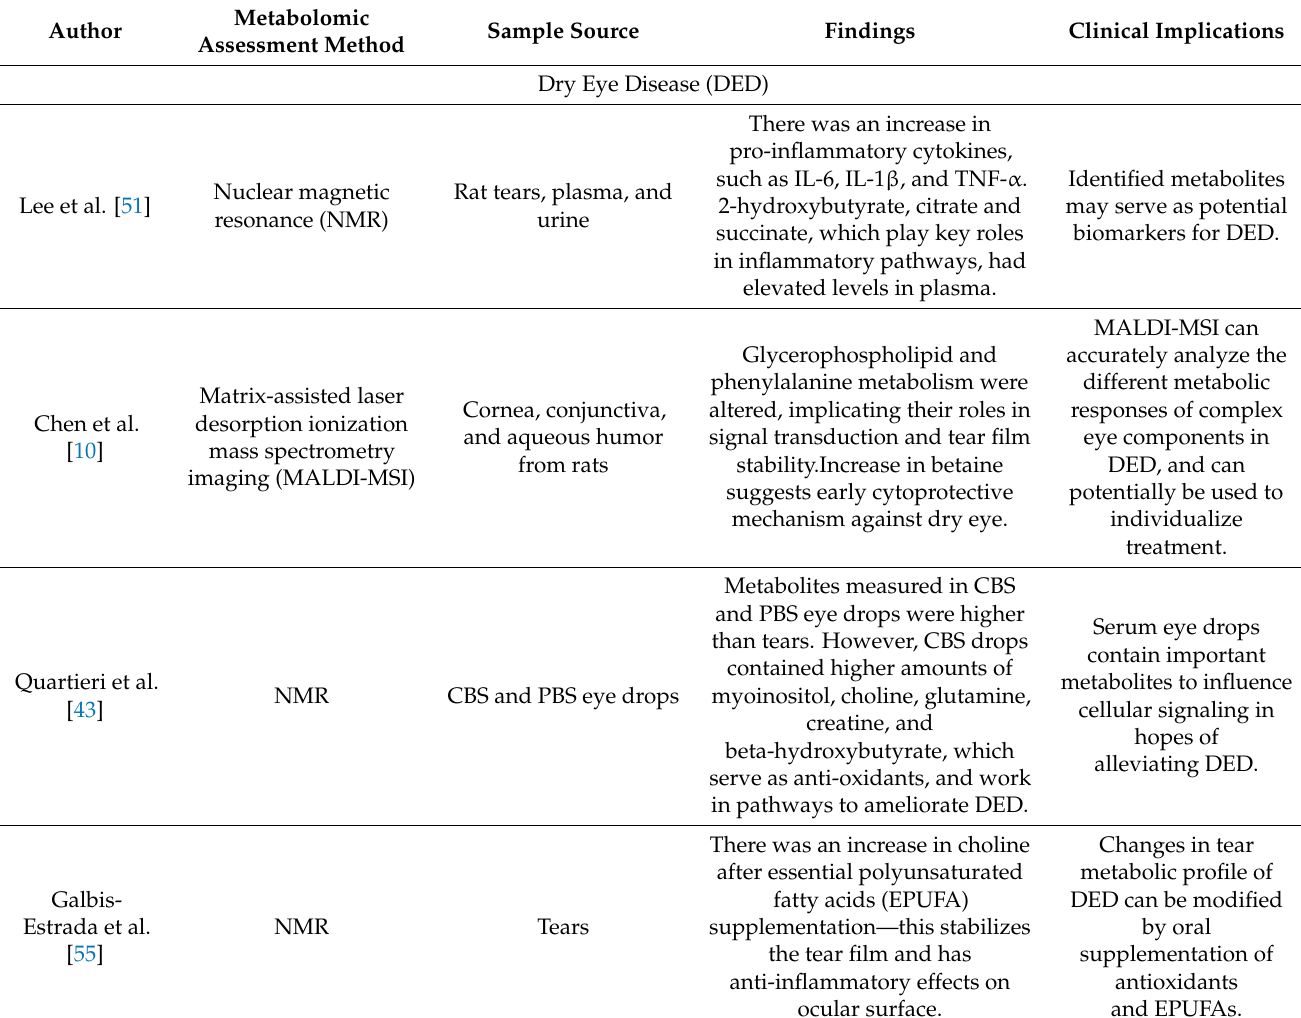
Table 1. Literature review of the metabolomic studies performed in corneal